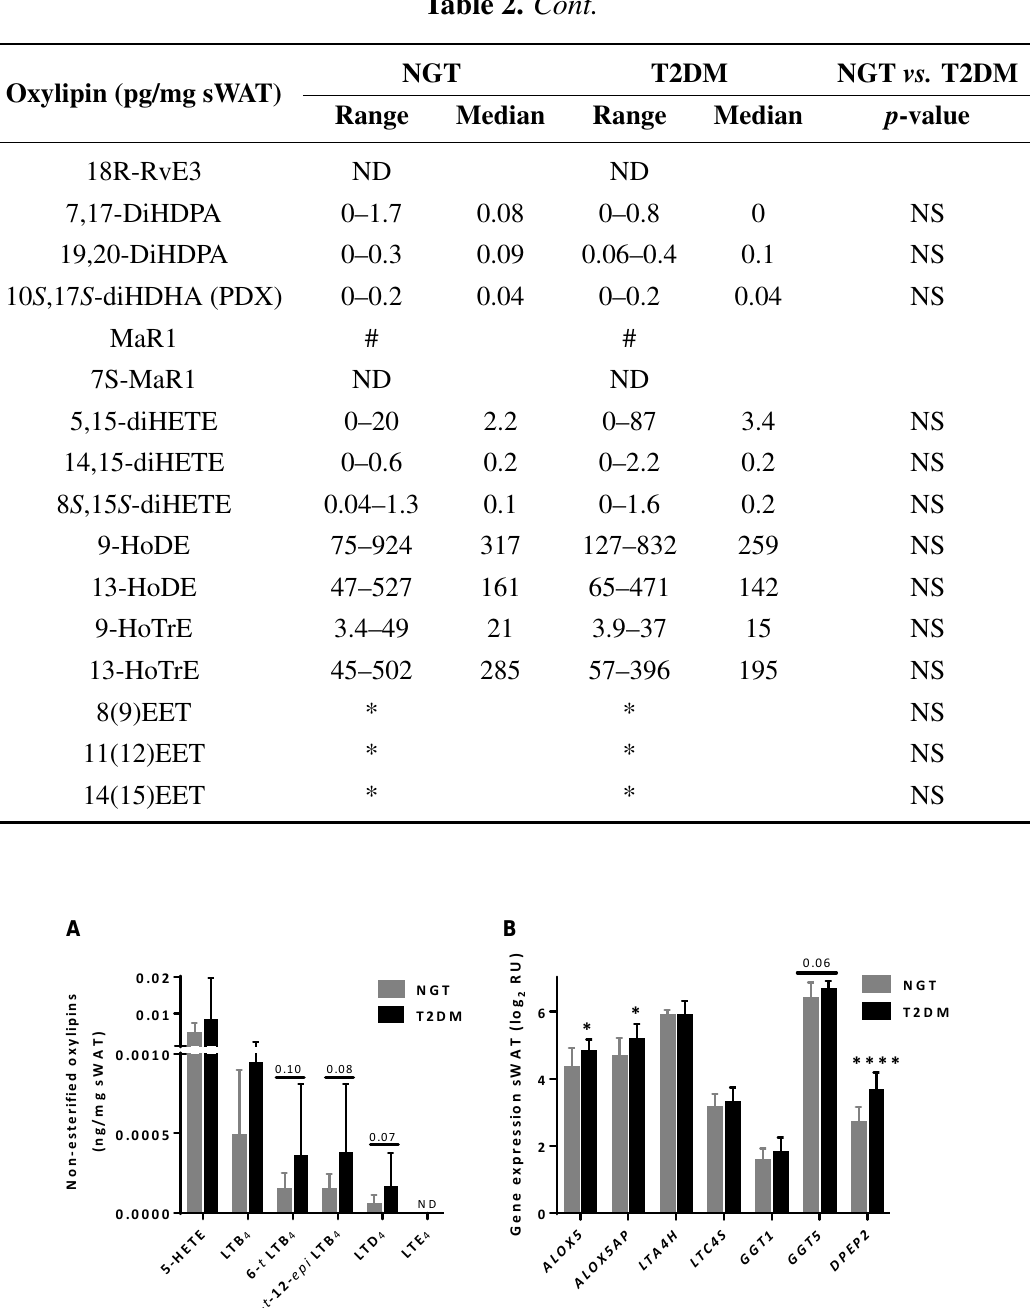
was below the 4